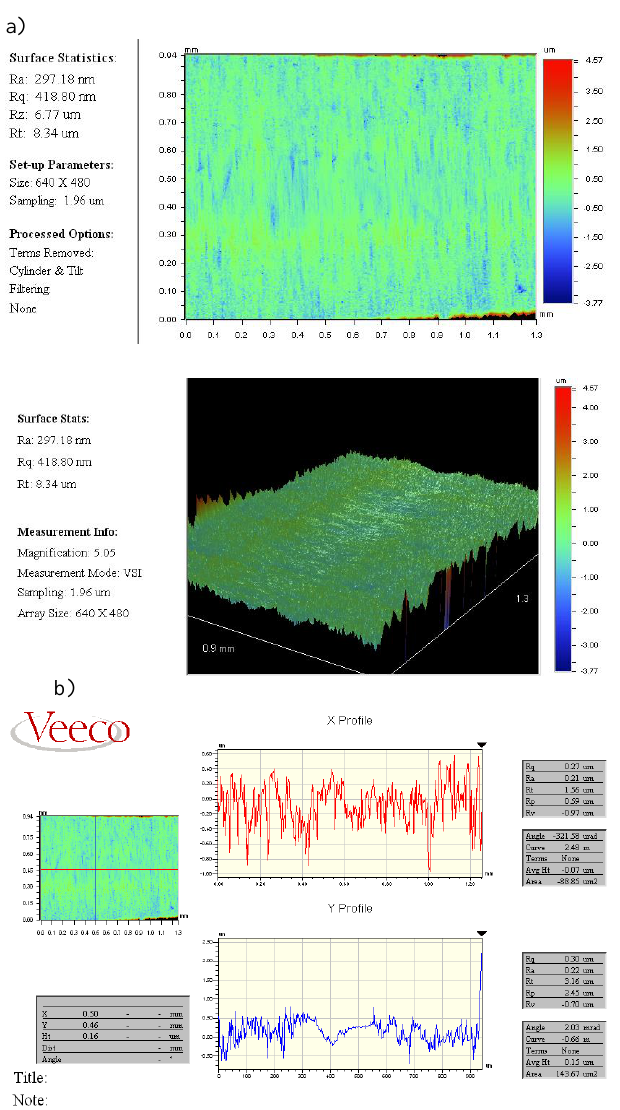
Fig. 3. Graphical results of testing the development (a) and roughness (b) of nozzle needle surface after the first test, for the first evaluated micro- area [4]